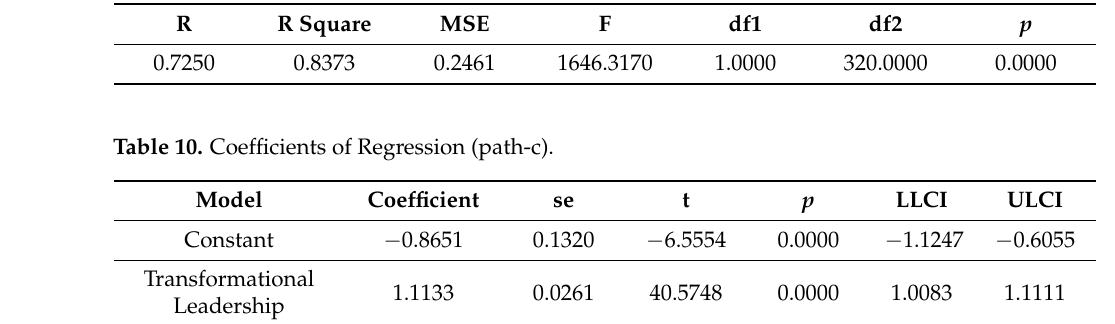
Table 9. Model Summary (path-c).